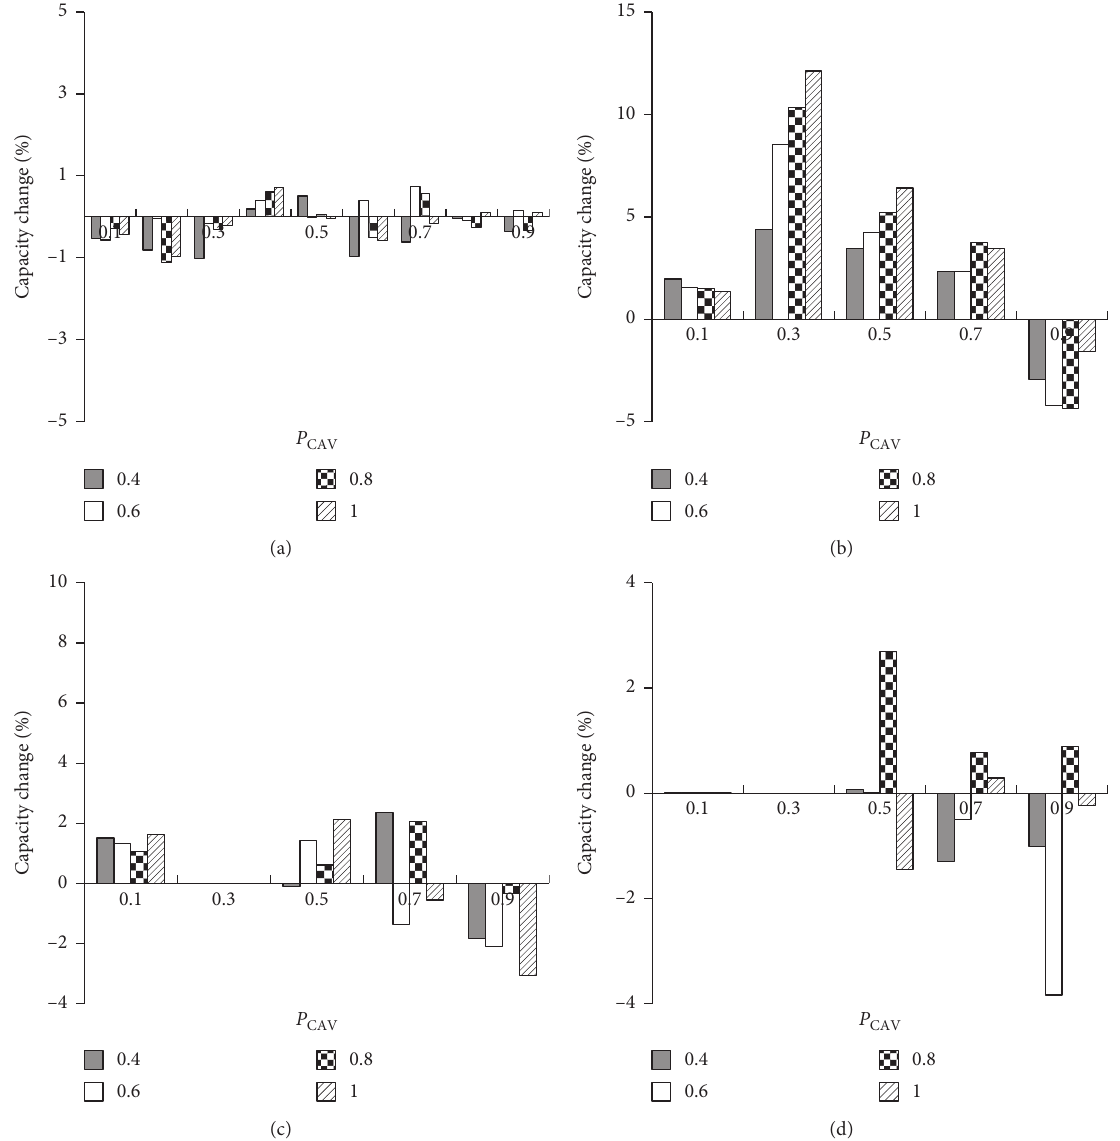
Figure 9: Relationship between capacity change and CAV penetration rate with different lane-changing probabilities of CAVs. (a) GGG. (b) GCG. (c) CGC. (d)